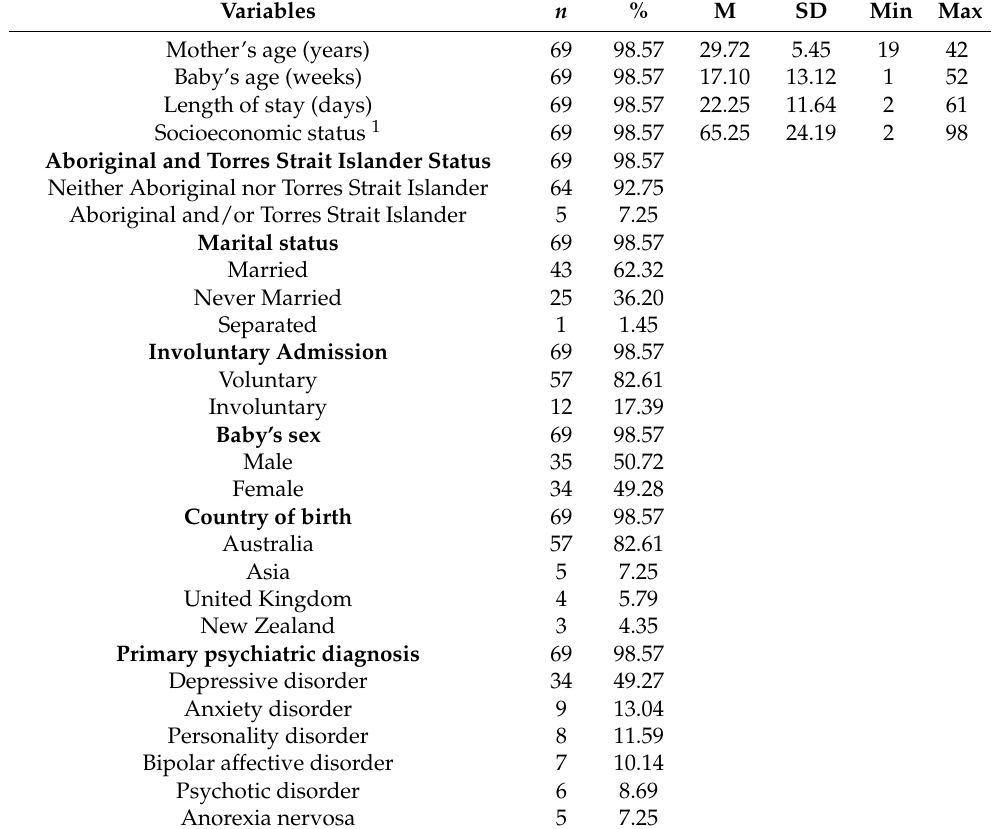
Table 1. Demographic Characteristics of the Present Study